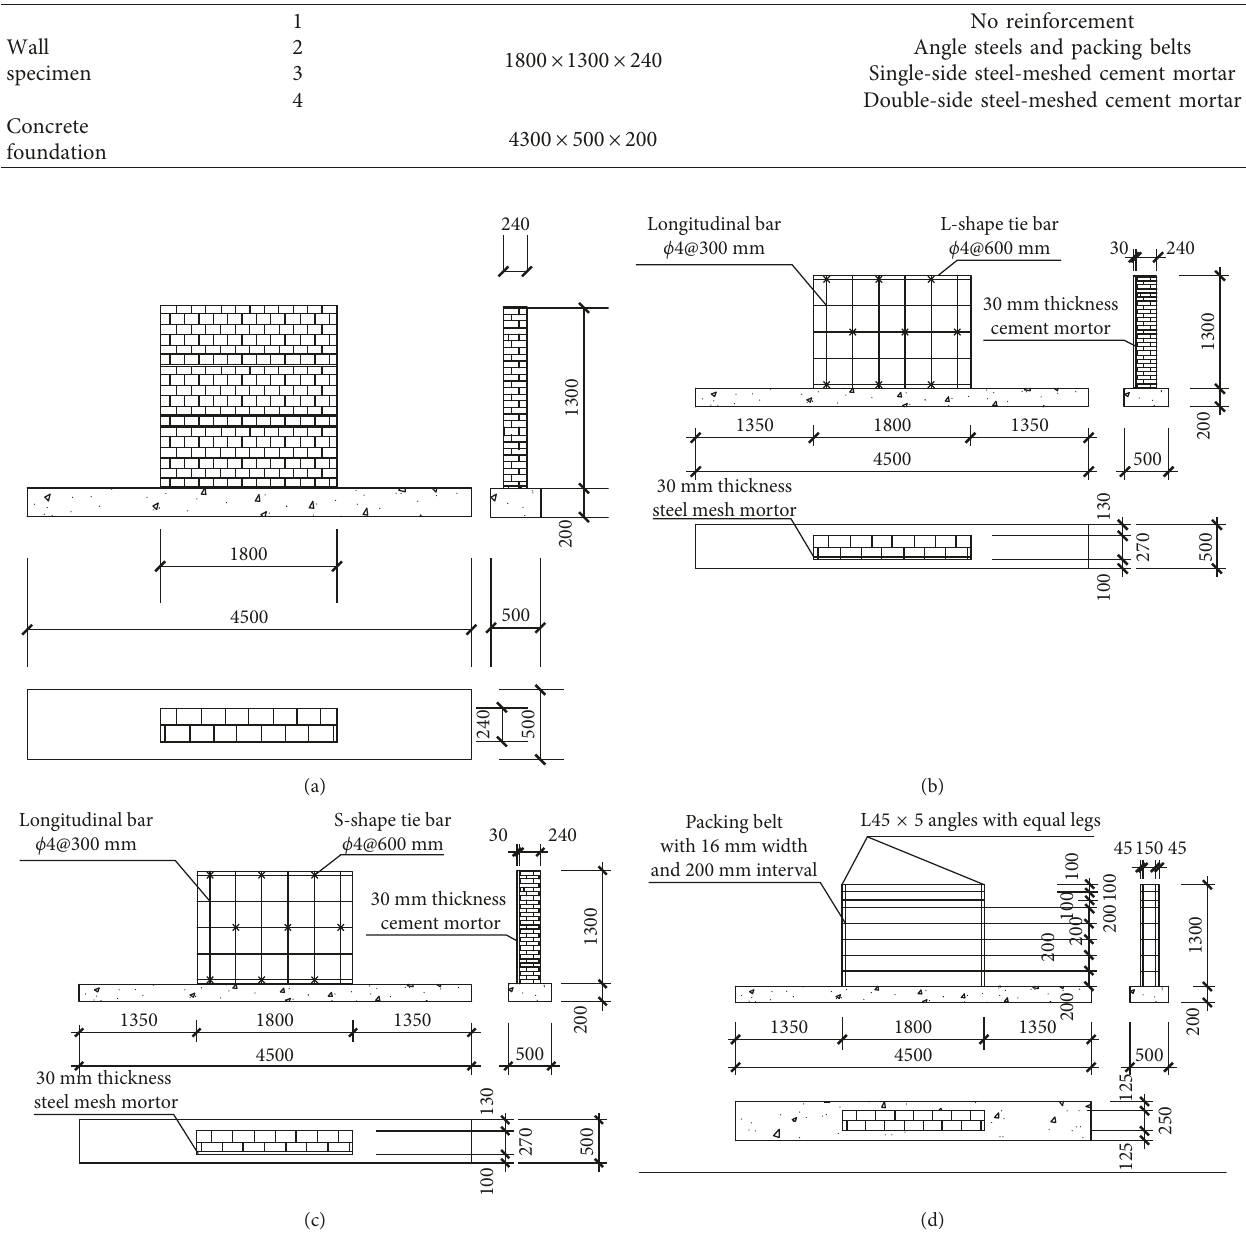
Figure 1: The forms of specimens: (a) specimen #1; (b) specimen #2; (c) specimen #3; (d) specimen